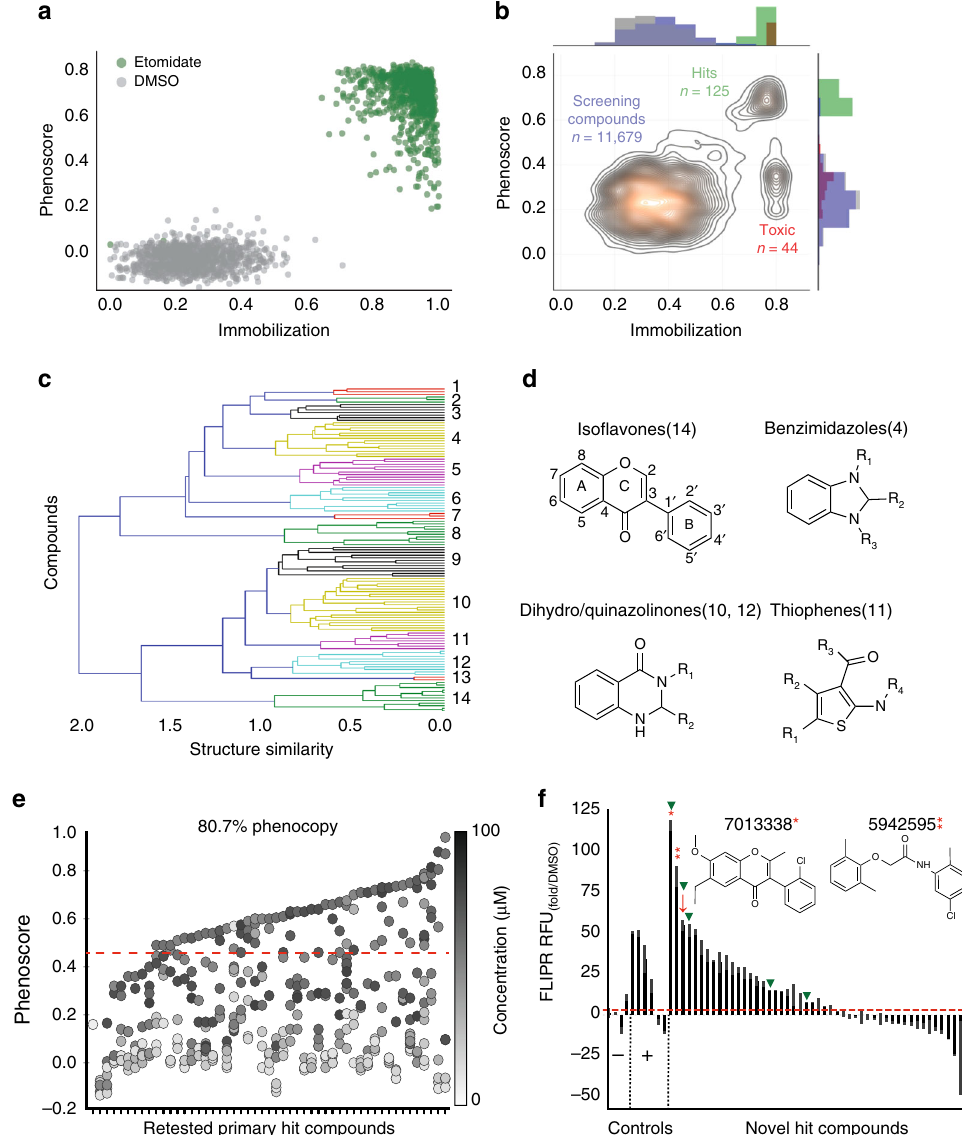
Fig. 2 A high-throughput behavioral screen identi fi es GABAergic compounds. Zebra fi sh were treated with various compounds and analyzed for anesthetic- related behaviors. a This scatter plot compares phenoscores of individual wells treated with DMSO or etomidate (6.25 μΜ ) (Z-factor = 0.7, n = 944 wells). b This contour plot scores each well from the large-scale behavior-based chemical screen (11,679 compounds, 2336 DMSO controls) by its phenoscore ( y -axis) and immobilization index ( x -axis). Labels indicate regions with 125 hit compounds (green), 44 toxic compounds (red), and the remaining screening compounds and DMSO controls (blue and gray, respectively). c Structural clustering of the top 125 hit compounds ( y -axis) forms 14 clusters using a Tanimoto similarity metric ( x -axis). d Example structures of selected compounds in the indicated clusters. e This scatter plot shows a 80.7% reproducibility rate for 57 primary hit compounds. Each point represents the average phenoscore of n = 12 wells at the indicated concentrations (colorbar). The fi rst column represents DMSO controls; the order of other compounds are listed in Supplementary Table 4. f Human GABA A R activation ( y -axis) was measured by FLIPR analysis. Of 47 hit compounds, 23 potentiated GABA A Rs. Compounds 7013338 and 5942595 potentiated GABA A Rs signi fi cantly greater than positive controls (red asterisk = 7013338, two red asterisks = 5942595, P < 0.0001, two-tailed t -test, n = 2 – 4 replicates as indicated). The hit threshold was de fi ned as 2× the average DMSO control group. Picrotoxin, BGC 20-761, progesterone, and DMSO were used as negative controls ( x -axis) while etomidate, tracazolate, propofol, diazepam, and thiopental were used as positive controls. Arrows indicate compounds that were predicted by SEA to bind GABA A Rs (red arrows) and compounds that bound to TSPO in vitro (green